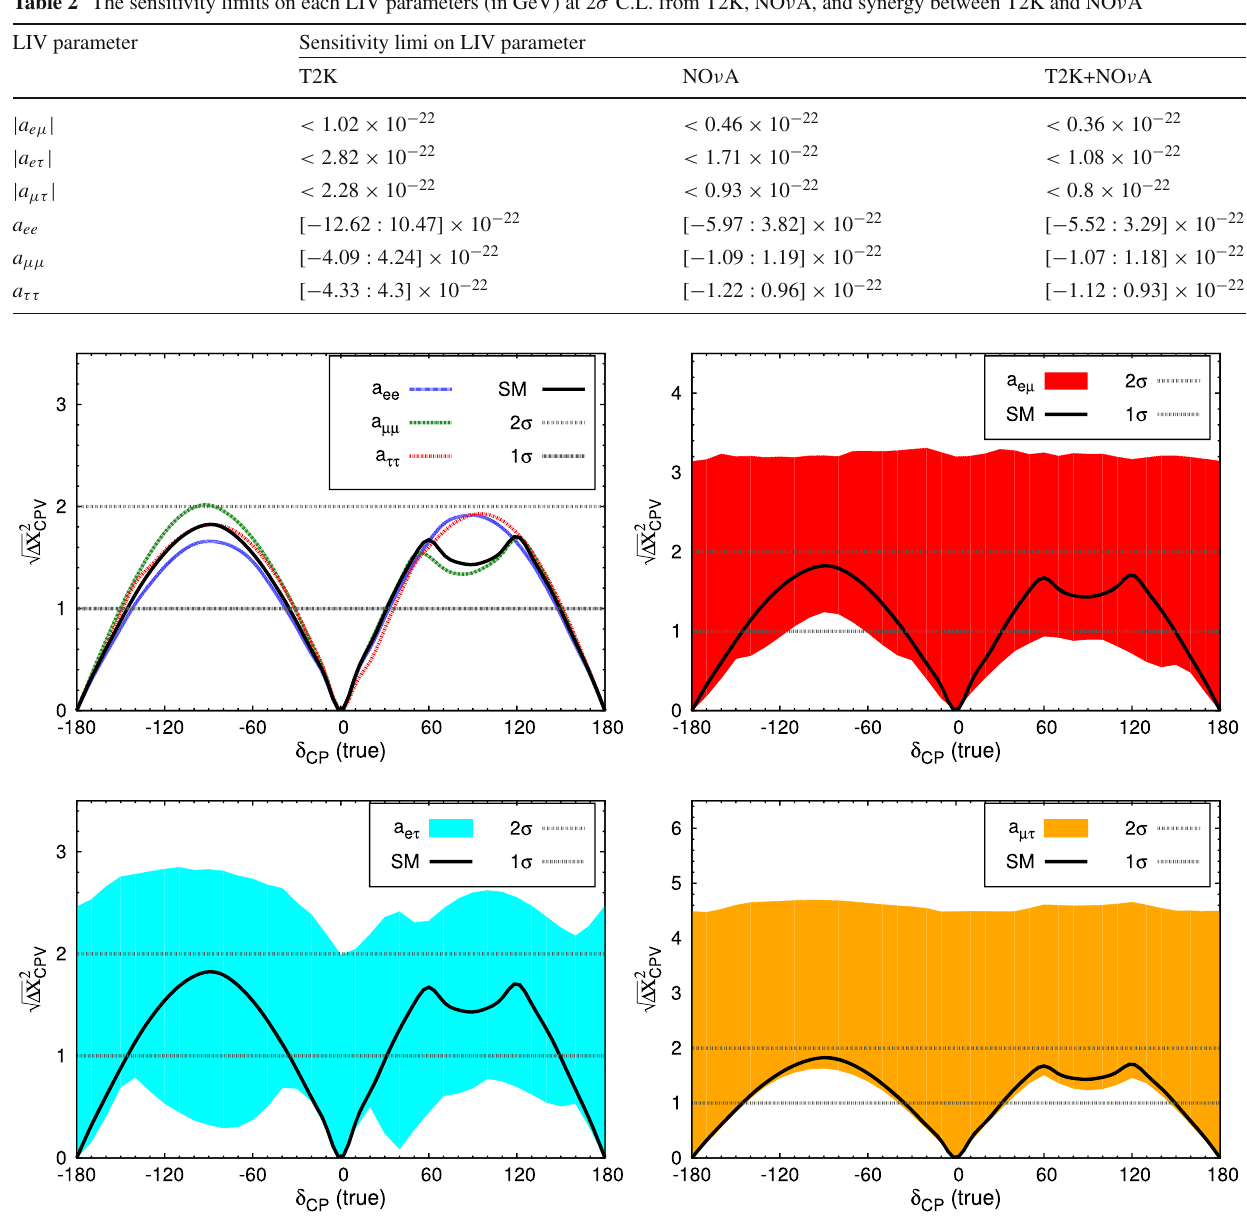
Fig. 5 CP Violation sensitivity as a function of true values of δ CP for NO ν A experiment. Standard case is represented by black curve in each plot. The top-left panel is for diagonal Lorentz violating parameters